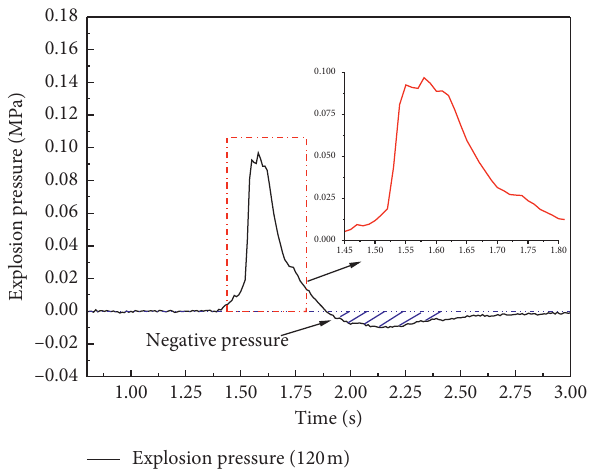
Figure 10: The explosion pressure-time curve at 120m from the point of